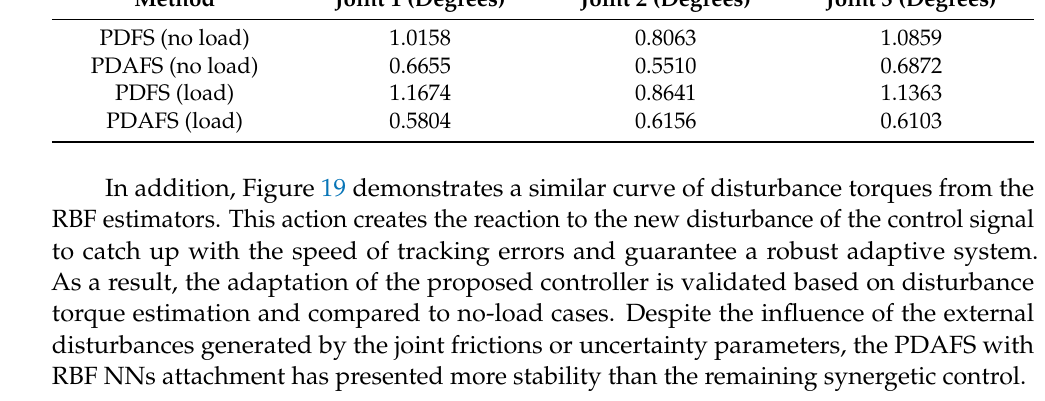
Figure 18. Control signals generated by the PDFS and PDAFS in case 2: joint 1 ( a ), joint 2 ( b ), joint 3 ( c ). In addition, Figure 19 demonstrates a similar curve of disturbance torques from the RBF estimators. This action creates the reaction to the new disturbance of the control sig- nal to catch up with the speed of tracking errors and guarantee a robust adaptive system. As a result, the adaptation of the proposed controller is validated based on disturbance torque estimation and compared to no-load cases. Despite the influence of the external disturbances generated by the joint frictions or uncertainty parameters, the PDAFS with RBF NNs attachment has presented more stability than the remaining synergetic control.